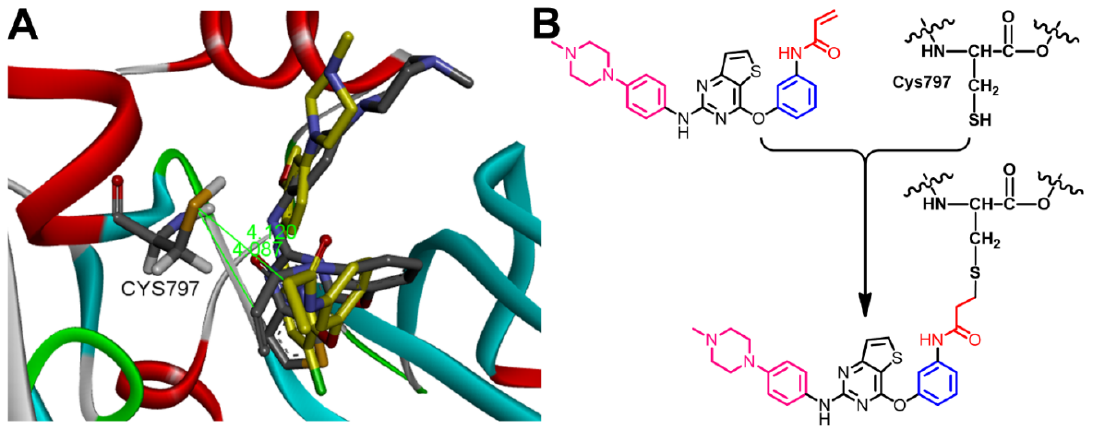
Figure 19. ( A ) 3D view of olmutinib (shown as sticks colored by element) overlaid with the co-crystallized WZ4003, showing the distance between β -carbon of Michael acceptor sites and the thiol group of Cys797; ( B ) proposed mechanism of the covalent interaction between olmutinib and EGFR.